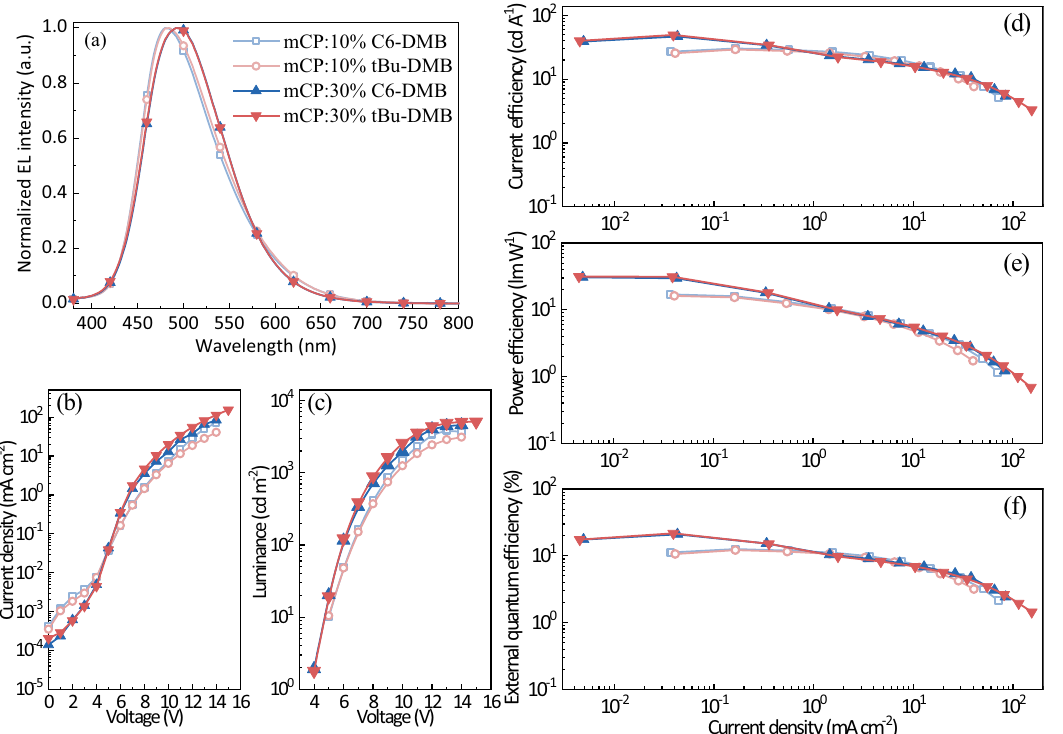
Fig. 5 Device performance of doped devices. a EL spectra; b current density to voltage curves; c luminance to voltage curves; d current ef fi ciency to current density curves; e power ef fi ciency to current density curves; f EQE to current density curves of doped devices.